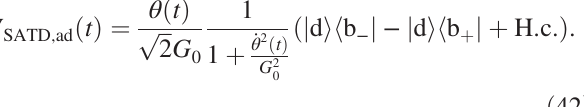
integrated the Schrödinger equation from t π = 2 arcsin ½ δ (cid:2)Þ = ν to t choice ensures that the control fields are small at both the initial and final protocol times: sin ½ θ ð t We take δ ¼ 10 − 6 .